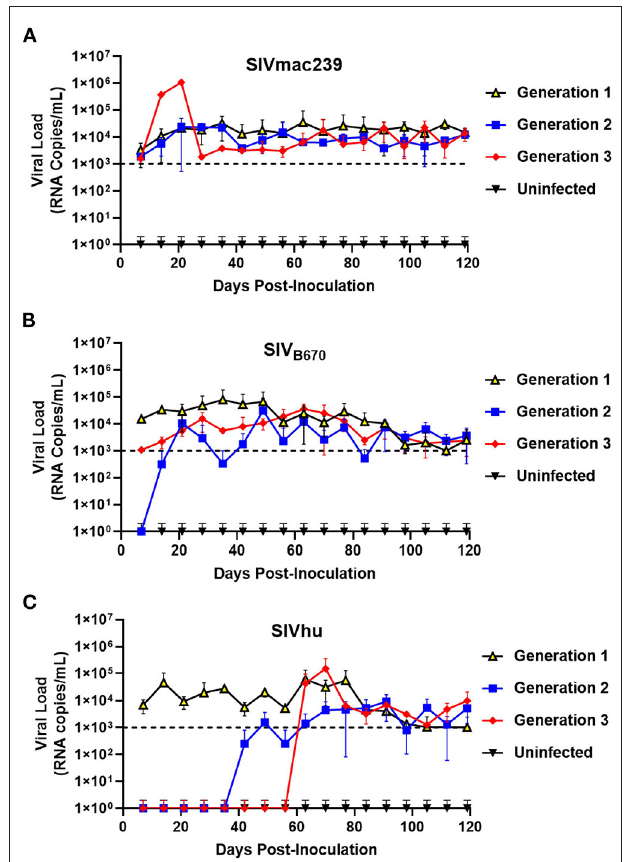
FIGURE 1 | SIVmac239, SIV B670 , and SIVhu can successfully initiate productive infection of hu-mice and are capable of serial transmission. (A) SIVmac239, (B) SIV B670 , and (C) SIVhu plasma viral loads during three generations of serial passage. Plasma viral loads were assessed